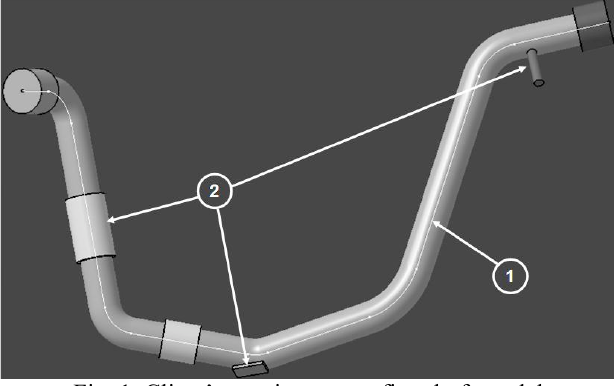
Fig. 1 . Client’s requirements - first draft model